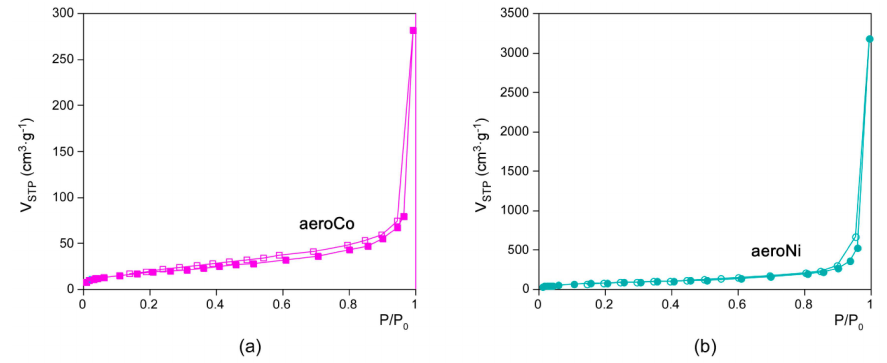
Figure 6. N 2 adsorption isotherms for ( a ) aeroCo and ( b ) aeroNi samples (filled symbol: adsorption branch; open symbol: desorption